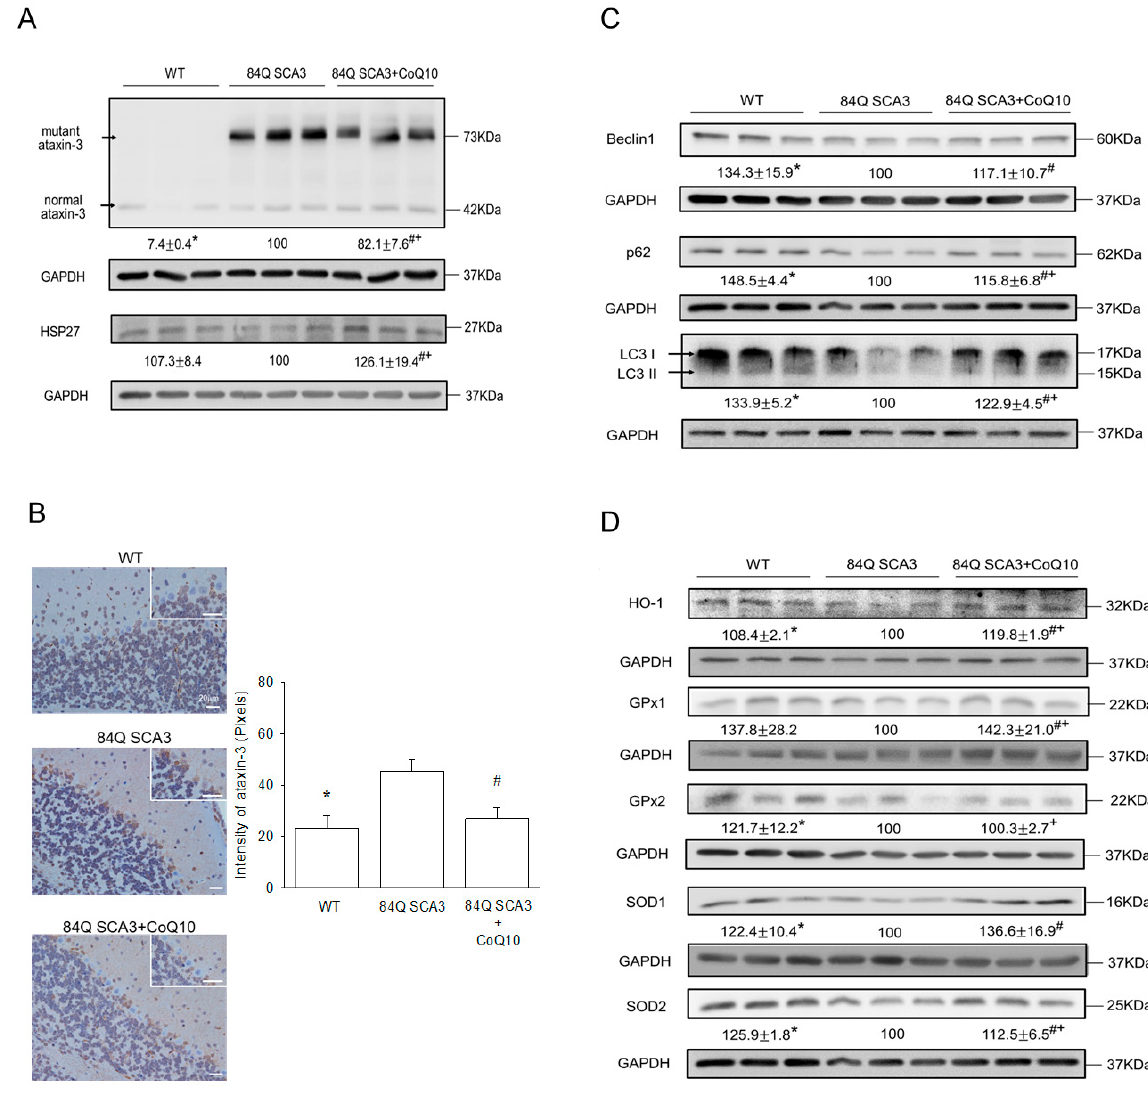
Figure 5. Effects of CoQ10 on the expression of mutant ataxin-3, Hsp27, autophagy and antioxidant protein expression in the cerebellum of 84Q SCA3 mice. ( A ) At the age of 16 months, the ataxin-3 expression of cerebellar extracts and ( B ) cerebellar tissue were analyzed by Western blot and immunobiological staining, respectively. Ataxin-3 expression in 50 Purkinje cells of the cerebellar cortex was quantified per group by collecting the magnification images shown in the upper right corner of the figure. ( A ) The expression of Hsp27 and ( C ) autophagy marker proteins, including p62, Beclin-1 and LC3-II, and ( D ) antioxidant proteins, including HO-1, GPx1, GPx2, SOD1 and SOD2 in cerebellar extracts, were analyzed by Western blot. All protein expressions were calculated by normalizing the internal control (GAPDH) prior to a comparison between groups. Values from treated mice were normalized to those of the 84Q SCA3 group. Data are presented as the mean ± SD. * p < 0.05 indicates the WT group compared to the 84Q SCA3 group. # p < 0.05 indicates the 84Q SCA3 + CoQ10 group compared to the 84Q SCA3 group. + p < 0.05 indicates the 84Q SCA3 + CoQ10 group compared to the WT group. WT, wild-type controls; 84Q SCA3, chow diet of vehicle; 84Q SCA3 + CoQ10, CoQ10